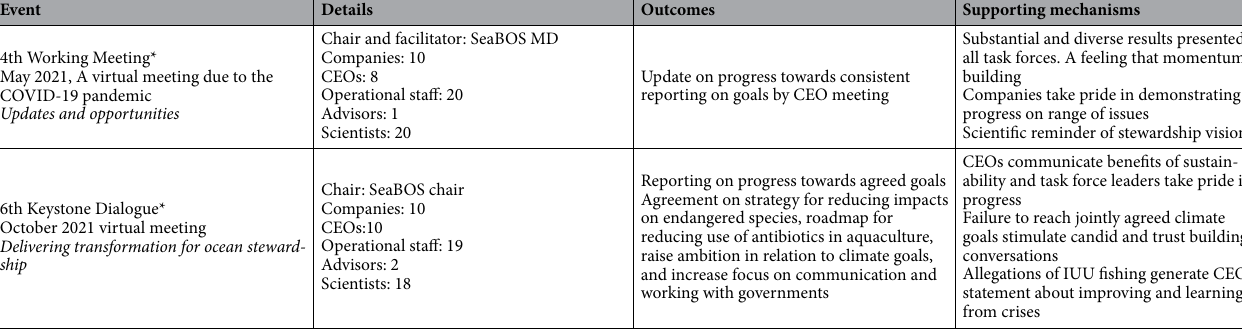
Unregulated. *HRH Crown Princess Victoria of Sweden